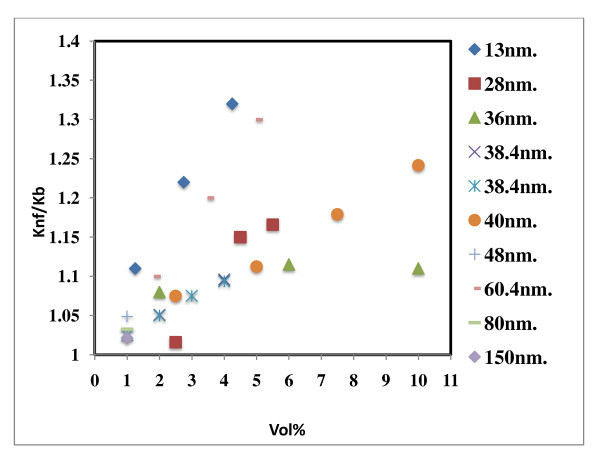
Effect of particle size on thermal conductivity of water-based Al2O3 nanofluids. 13 nm [15], 28 nm [8], 36 nm [13], 38.4 nm [1], 38.4 nm [7], 40 nm [14], 48 nm [17], 60.4 nm [16], 80 nm [20], 150 nm [20].